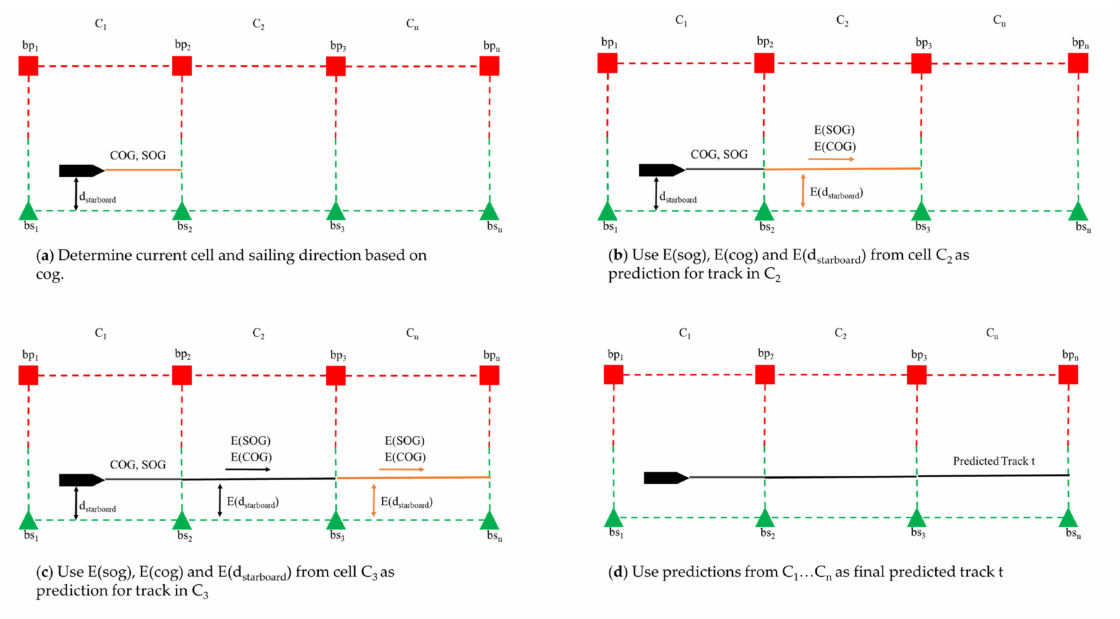
Figure 3. We predict the behavior of a vessel within each cell of the waterway, using the expected values for the parameters COG, SOG, and d starboard in each cell ( a – c ). Each prediction is combined, which yields the final predicted track through the entire waterway ( d